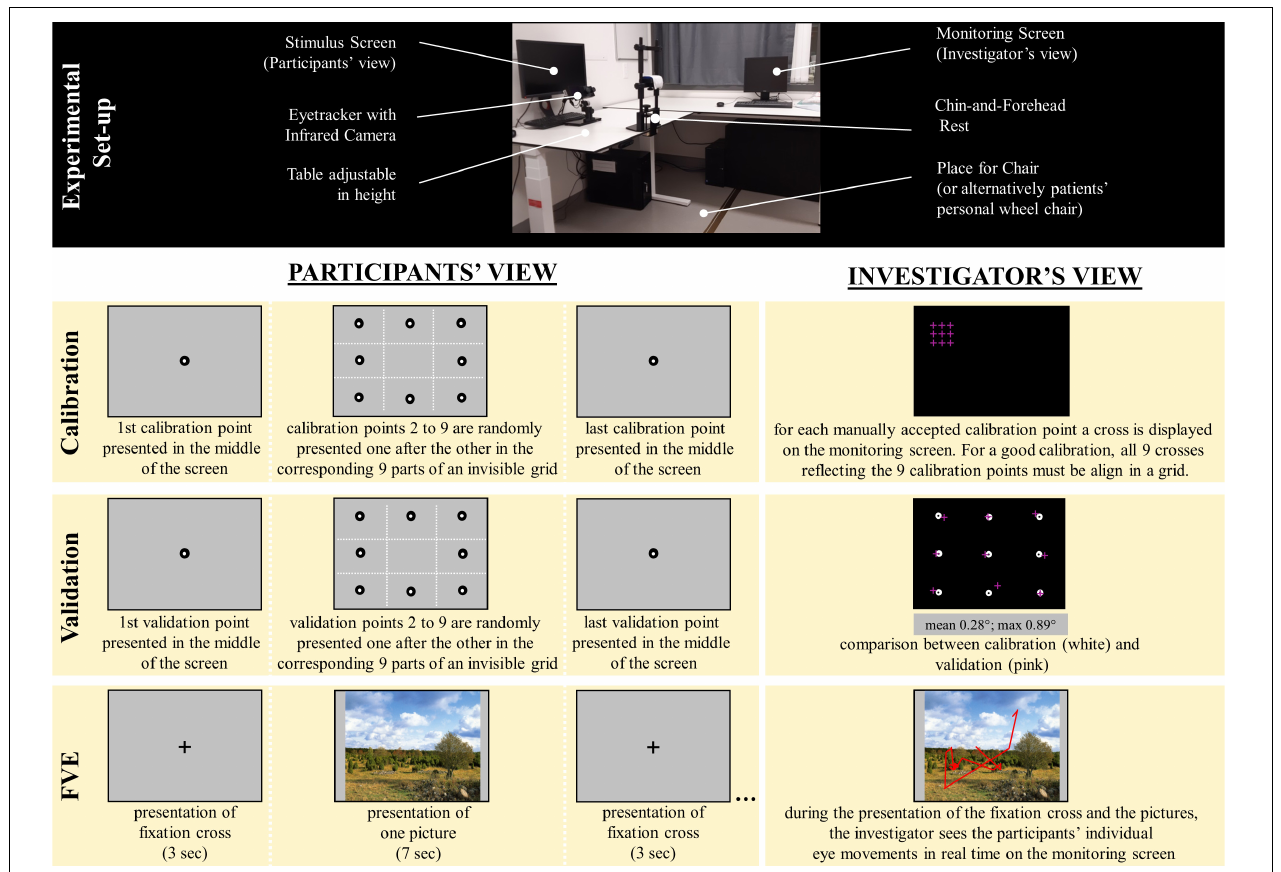
FIGURE 2 | Experimental set-up of FVE and Participants’/Investigators’ View during FVE. Top Experimental Set-up of the video-oculography equipment, consisting of a stimulus screen, on which the FVE paradigm is presented, and a Monitoring Screen, on which the investigator can monitor the patients’ individual eye movements during testing. Eye movements are recorded using an infrared-based camera (e.g., Eyelink 1000 Plus by SR research). A height-adjustable table can be adapted to find the optimal configuration of the experimental set-up for each patient. Furthermore, a height-adjustable table allows examining patients in a wheel-chair, wherefore usually additional table height is needed to fit the armrests. A chin-and-forehead-rest was used to both ensure that the mid-sagittal plane of the patients was aligned with the middle of the screen at a constant distance, and to minimise head movements. Bottom Left shows the participants’ view of the stimulus screen during Calibration (top), Validation (middle), and during the Free Visual exploration (FVE) Paradigm (bottom). Bottom Right shows the Investigator’s View on the monitoring screen during Calibration, Validation, and during